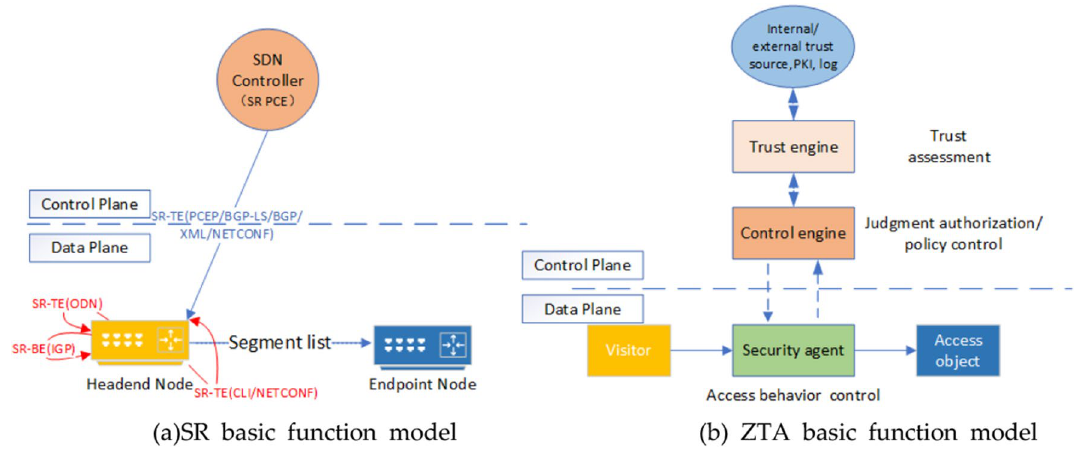
Figure 1. SR basic function model and ZTA basic function